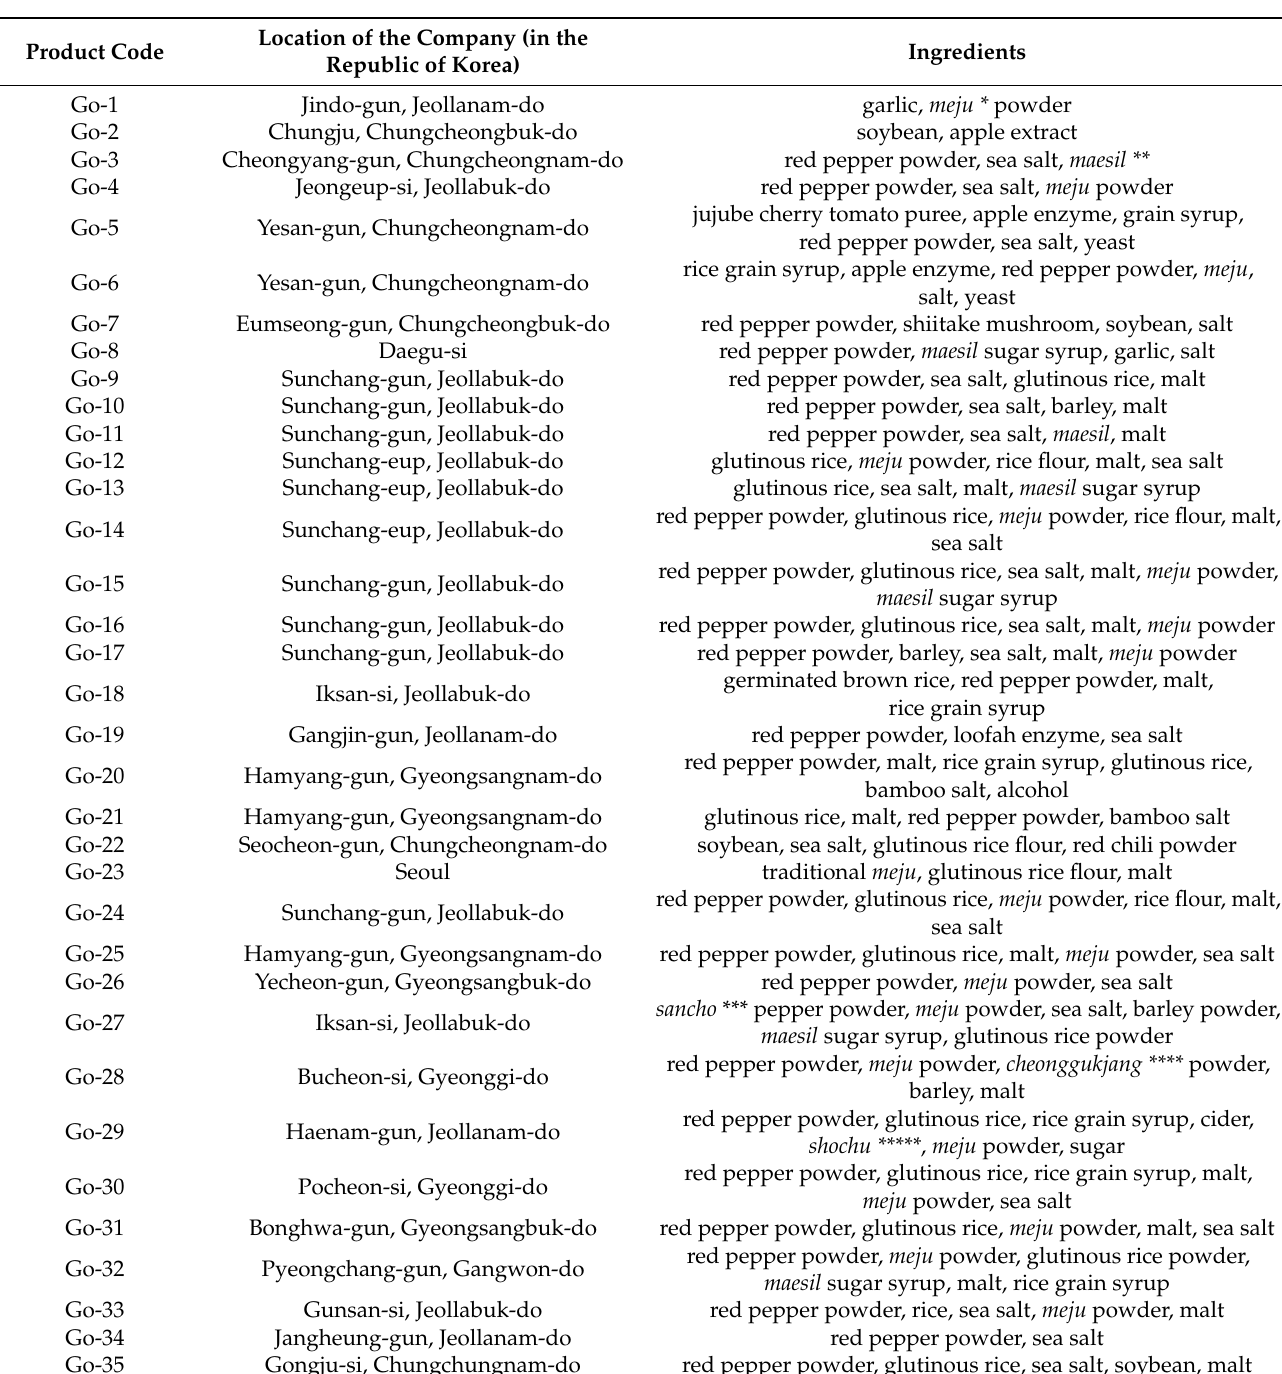
Table 1. Details of the selected gochujang